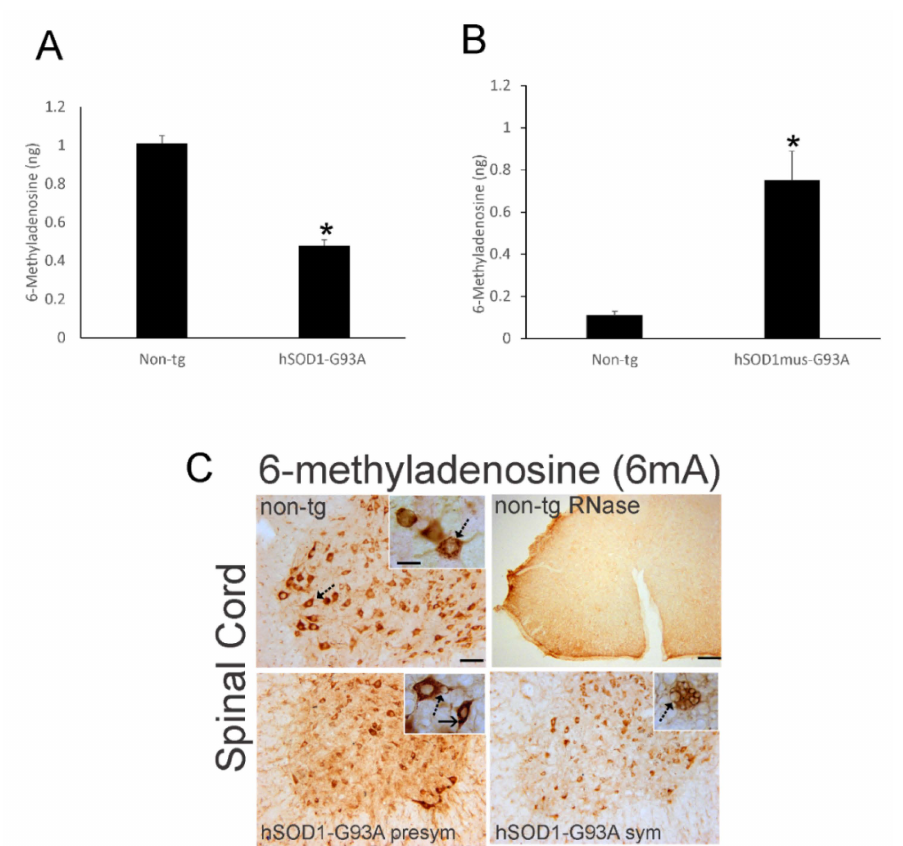
Figure 9. 6mA RNA methylation is abnormal in hSOD1 mouse ALS. ( A ) ELISA for m6A content (nanogram [ng], mean ± SD, n = 6/group) in whole spinal cord of presymptomatic (6 weeks old) nonconditional hSOD1-G93A tg mice and age-matched littermate non-tg control mice. * p < 0.001. ( B ) m6A ELISA (mean ± SD, n = 6/group) for whole spinal cord of presymptomatic (12 months old) conditional hSOD1-G93A mus tg mice and age-matched littermate non-tg control mice. * p < 0.001. ( C ) IHC for 6mA (brown staining) in lumbar spinal cord ventral horn of presymptomatic (6 weeks old) and symptomatic (12 weeks old) nonconditional hSOD1-G93A tg mice and non-tg control mice. 6mA is enriched in MNs (non-tg, hatched arrow). Insets show MNs (arrows) at higher magnification. Mutant hSOD1-G93A mouse MNs have cytoplasmic vacuoles (hatched arrows) or round strongly positive cytoplasmic 6mA inclusions (solid arrow). For a negative control, spinal cord sections were pretreated with RNase that abolished the IR for 6mA. Non-tg mouse sections were use for RNase treatment because they had the strongest IR. Scale bars: ( C ) non-tg (same for presym and sym), 40 µ m; inset (non-tg, same for others), 10 µ m; ( C ) non-tg RNase, 100 µ